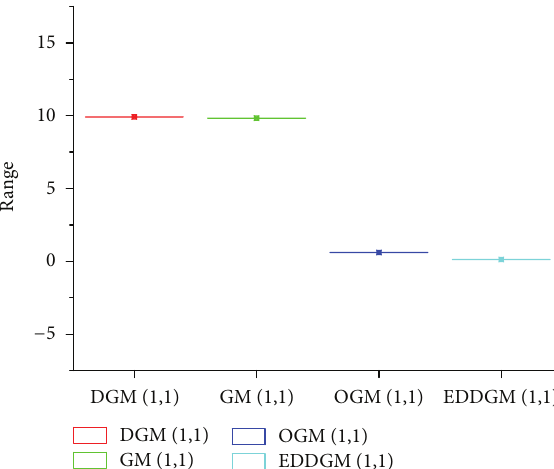
Figure 6: Prediction relative errors of four